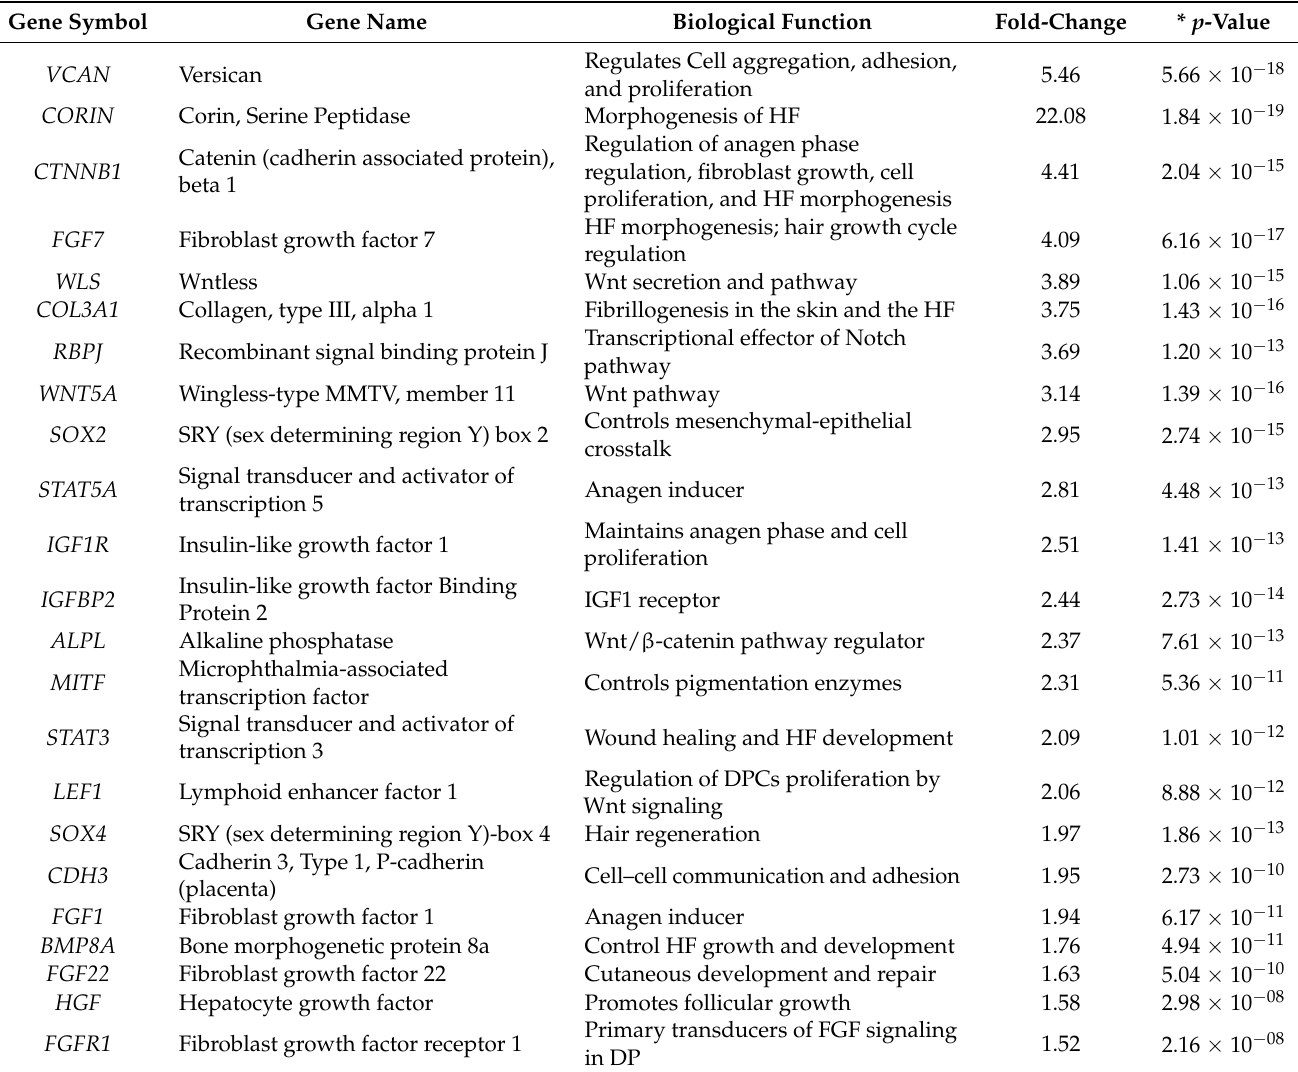
Table 2. Summary of the top upregulated hair growth-associated genes by